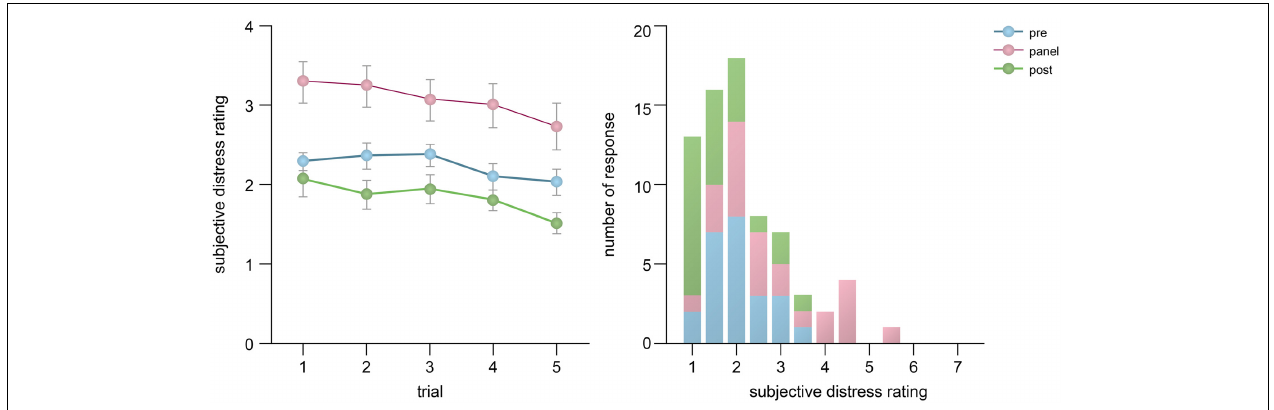
FIGURE 2 | Changes in one-item Likert scores across trials and their distribution. The Likert scores obtained before and after a trial were averaged. The error bars represent one standard error.